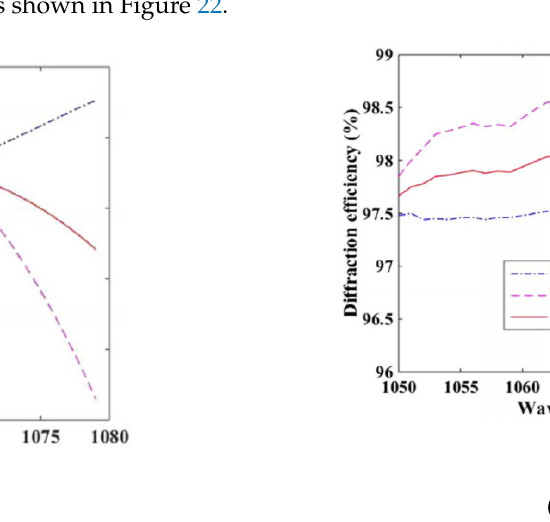
Figure 21. SEM image of the as ‐ prepared grating.